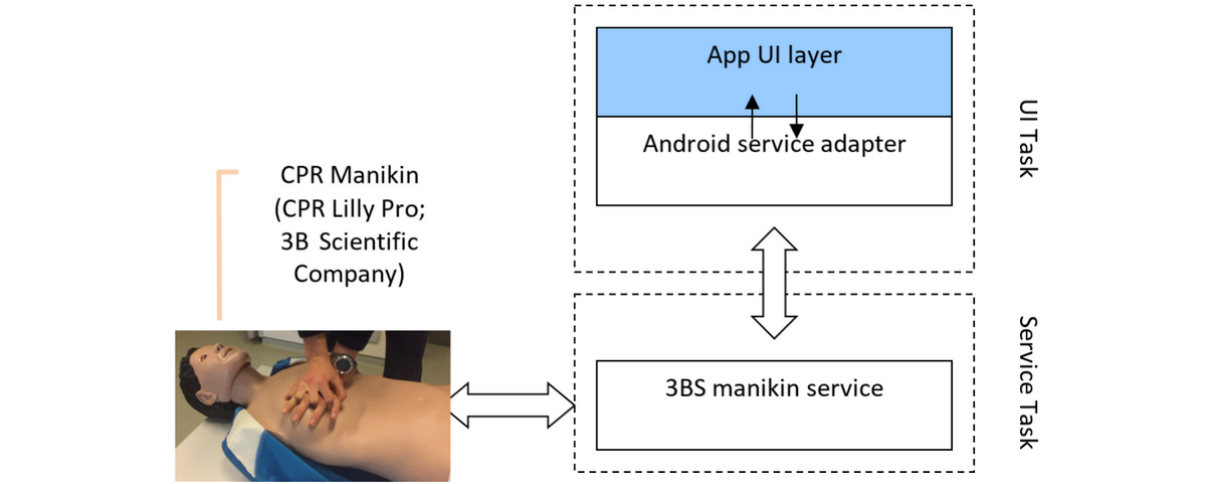
Figure 8. Android App